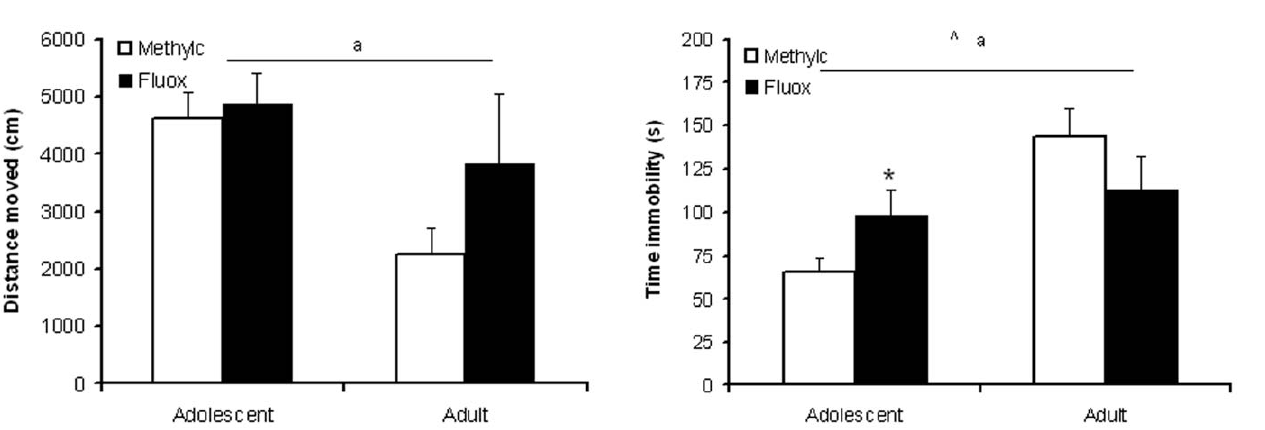
Figure 4. Effect of fluoxetine treatment on behavioral despair in adolescent and adult rats. Data are presented as mean 6 S.E.M. of time spent on immobility (n=10). 10 Days following chronic fluoxetine treatment (12 mg/kg) behavioral despair, expressed as immobility in the forced swim test, was increased in adolescent, but unaffected in adult rats. a p , 0.05 main age effect; ‘ p , 0.05 age x treatment interaction; * p , 0.05 fluoxetine versus methylcellulose in age group.